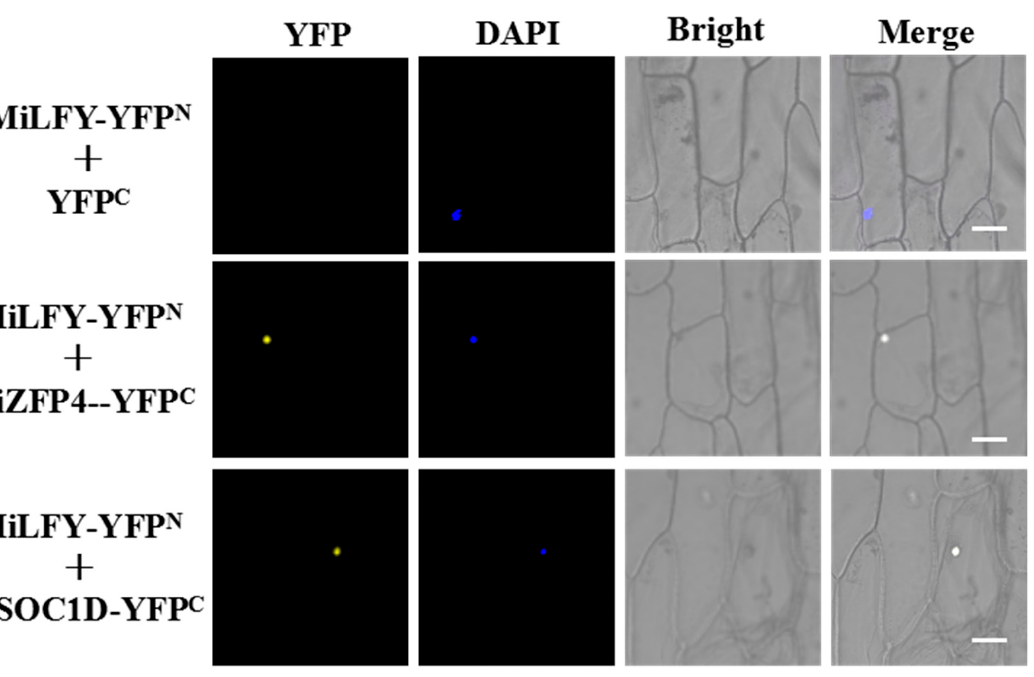
Figure 8. BiFC assays of MiLFY and candidate proteins. Bars=20 μ m.